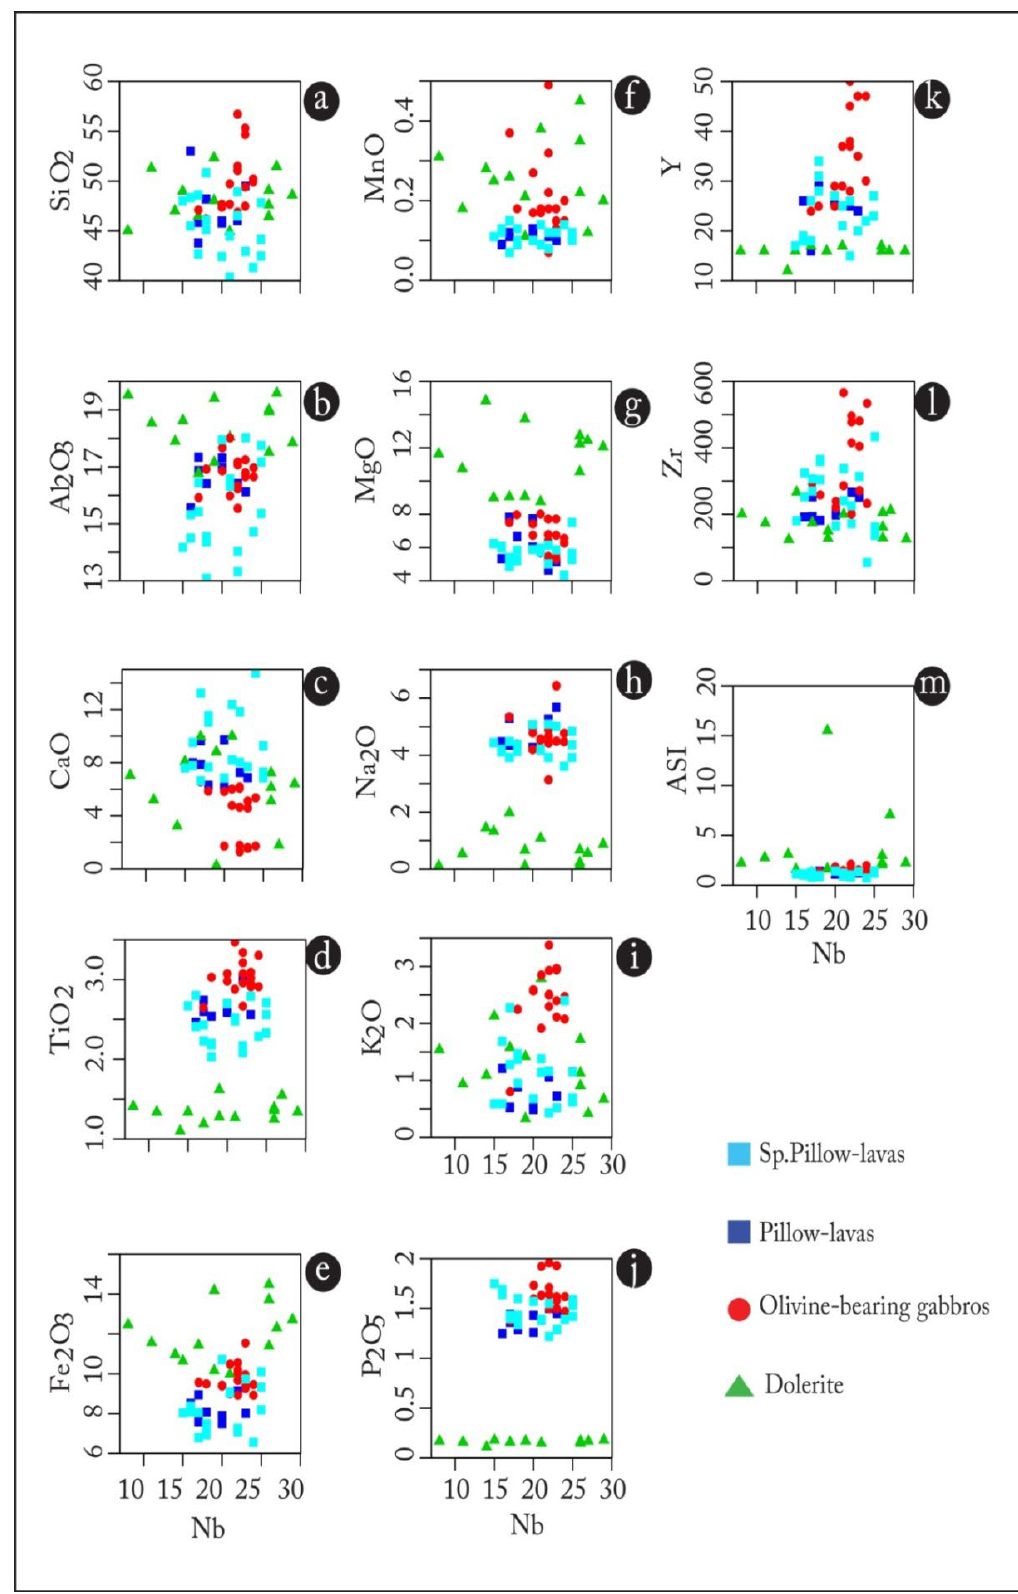
Figure 18. Variations of selected major (wt%) ( a – j ), trace element (ppm) ( k , l ) and Alumina Saturation Index: ASI = Al/(Ca + Na + K) molar ( m ) contents vs. Nb (ppm) for the mafic and intermediate dikes in the NNE Achemmach.